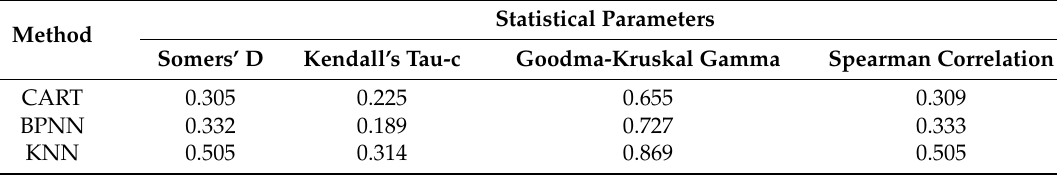
Figure 4. Maps of powdery mildew occurrence severity in winter wheat produced by the ( a ) CART, ( b ) BPNN, and ( c ) KNN models using optimal multi-temporal VIs. Table 5. Statistical measures of the goodness of fit for the optimal multi-temporal VIs-based CART, BPNN and KNN monitoring models.